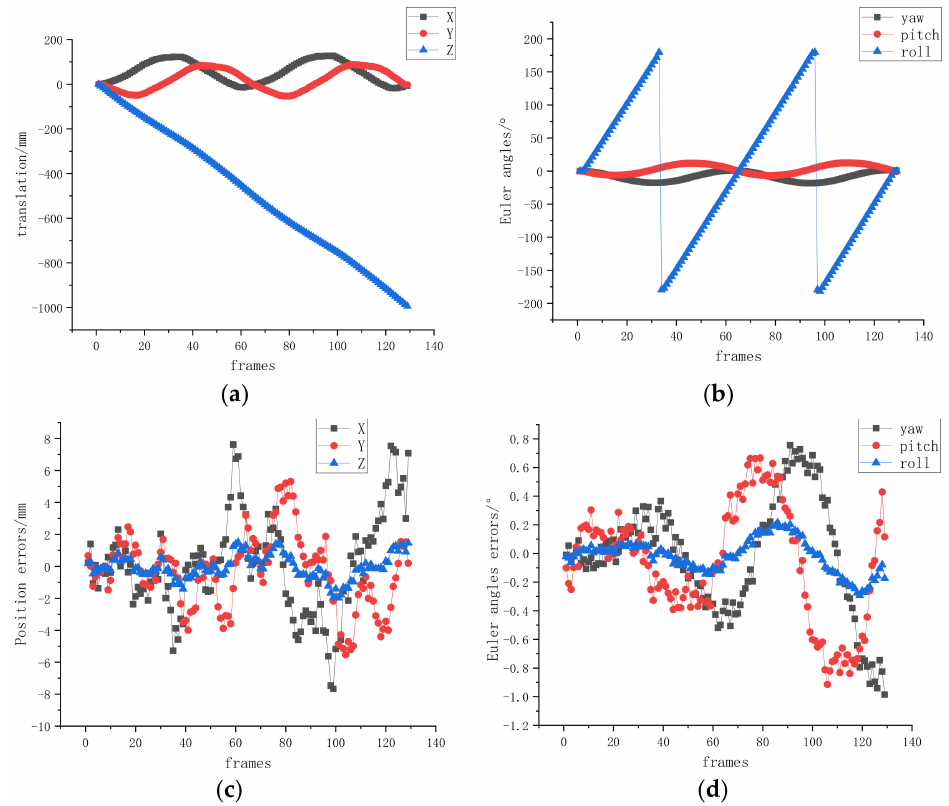
Figure 11. Pose-estimation results of our method for the translation experiment. ( a ) Translation of the XYZ axis; ( b ) Euler angle RPY of the YZX axis; ( c ) Position errors of the XYZ axis; ( d ) Euler angles error of the YZX